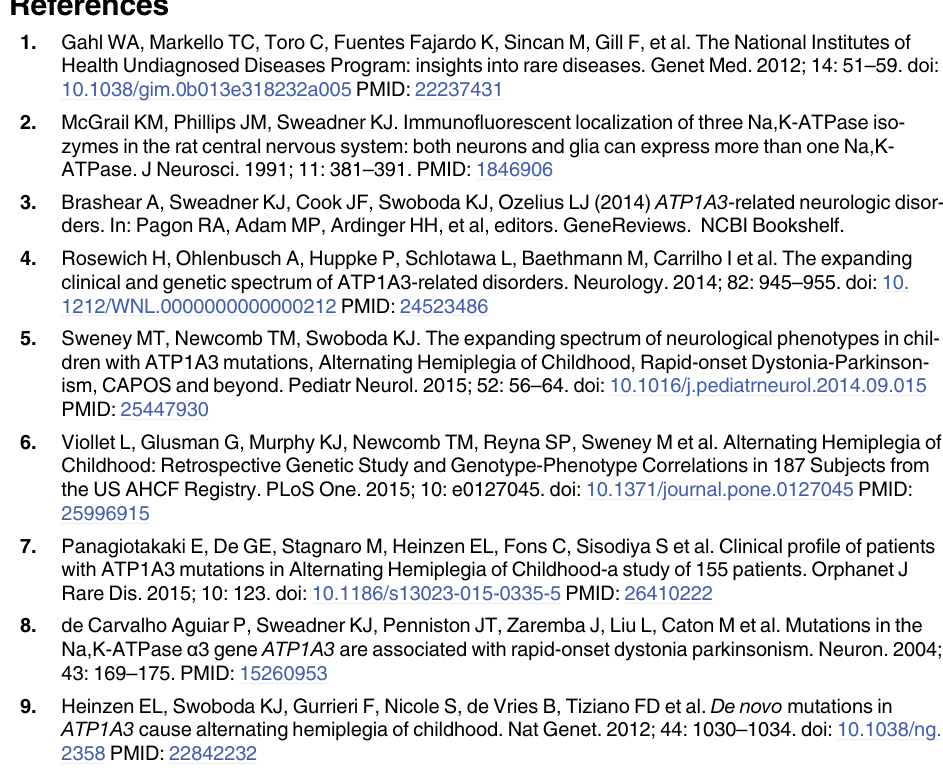
S1 File. Supplementary data. Table A. Psychiatric evaluation. Table B. Neuropsychological evaluation. Figure A. Redundancy of the deleted motif in GPRIN1